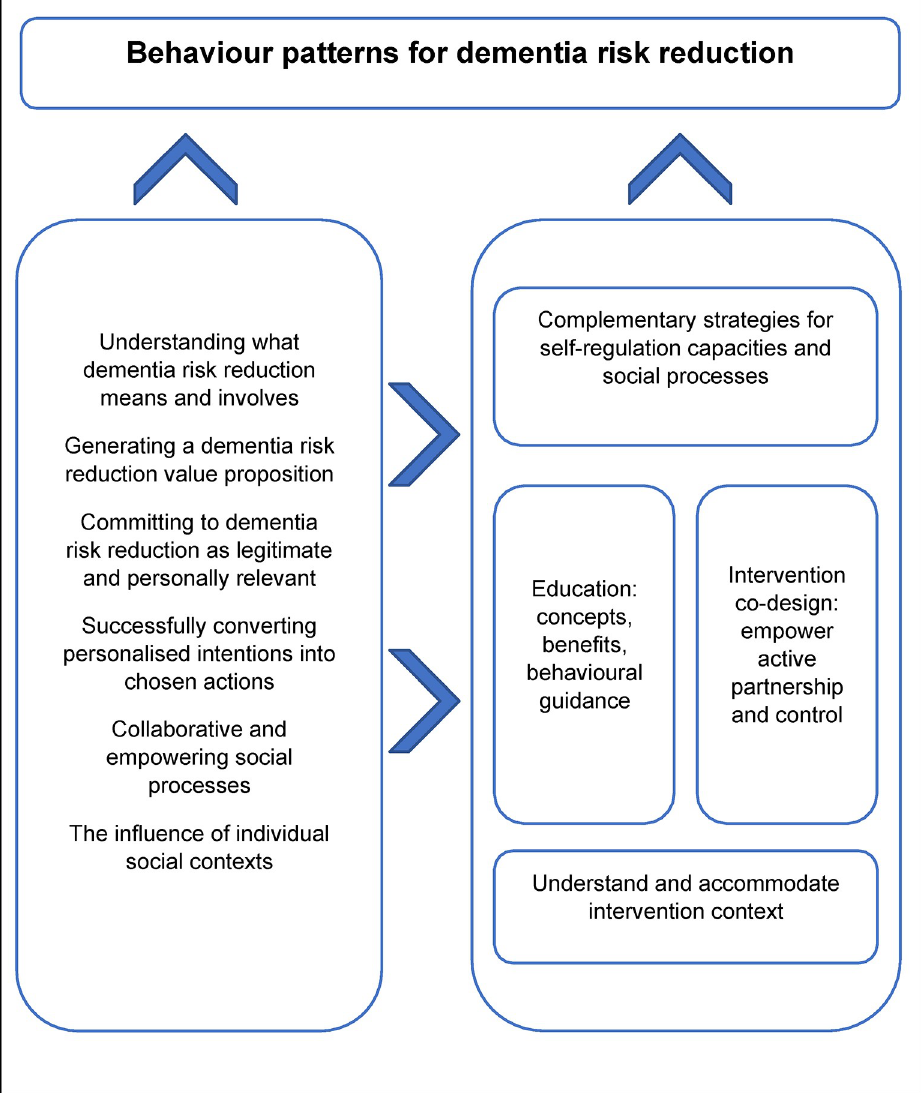
Fig 4. An integrated model of general population dementia risk reduction perspectives and approaches to intervention. The model suggests key considerations for approaching interventions to support individuals to adopt and maintain dementia risk reduction behaviour patterns. Detailed understanding of intervention context should be used to co-design tailor and detail intervention approaches based on this model. Education is key and should be complemented by tailored strategies to: support self-regulation; and develop and leverage supportive social environments, skills and resources. Themes, adapted to context, should inform the specific strategies used and their